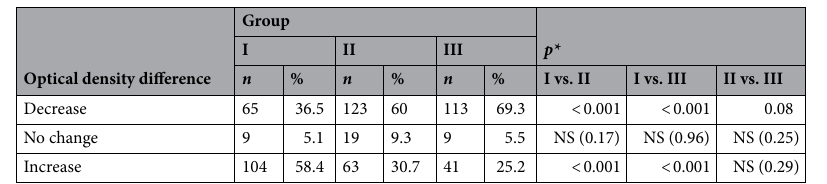
Table 4. Changes of optical density differences in particular groups—results after 1 year (baseline vs. follow-up 1). *p < 0.05 significant.